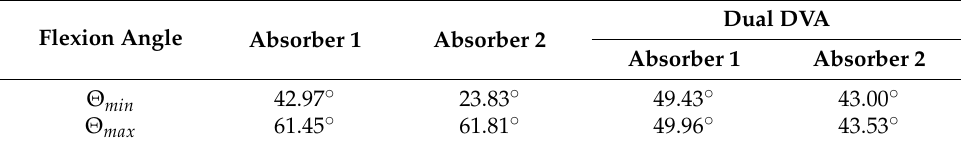
Table 7. Minimum and maximum flexion angle of the absorbers in time domain for c a = 0.0002 k a .